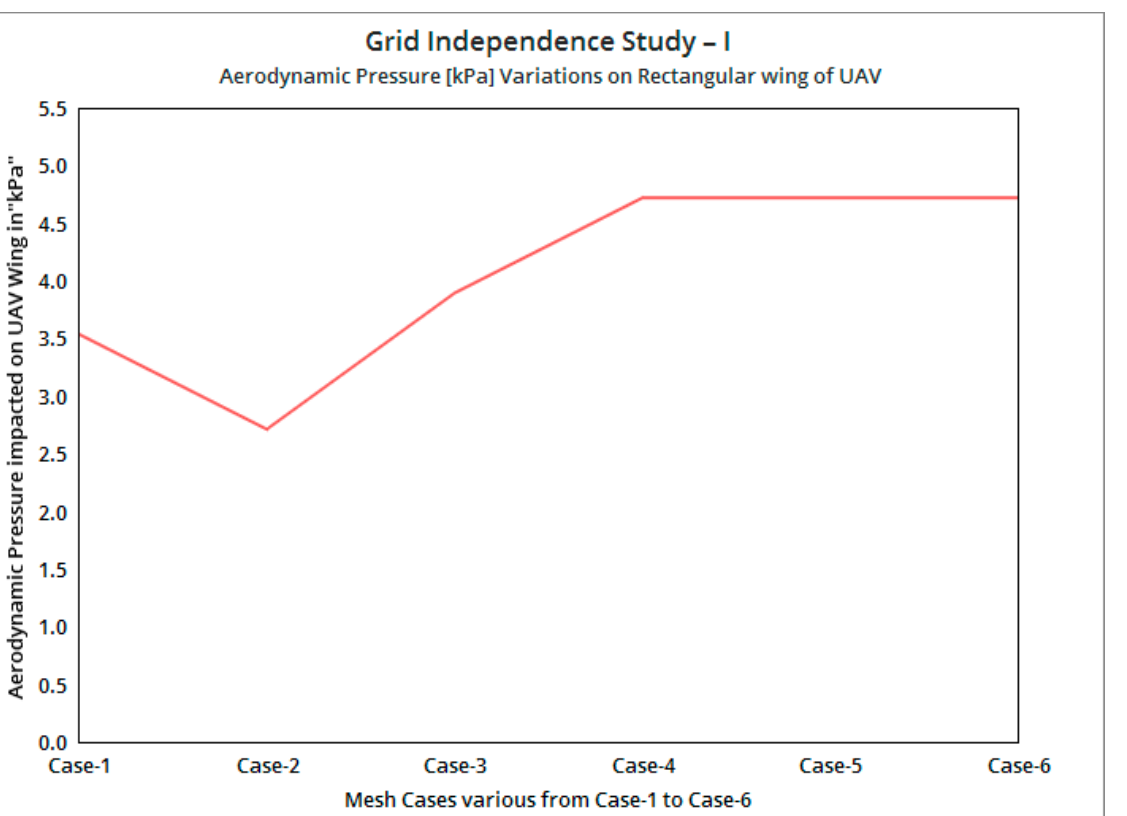
Figure 13. Grid convergence test 2: natural frequency of KFRPwind turbine blade.